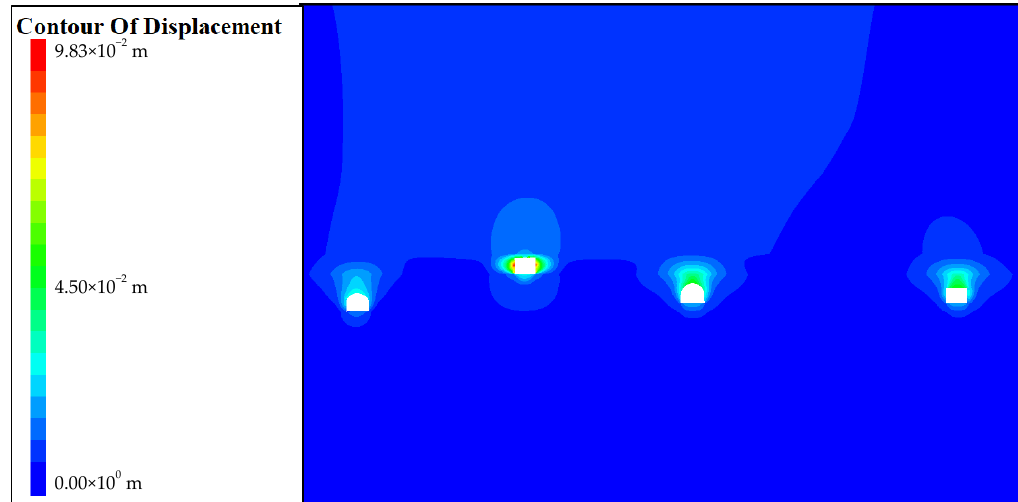
Figure 10. Displacement of surrounding rock behind the excavation roadway group.